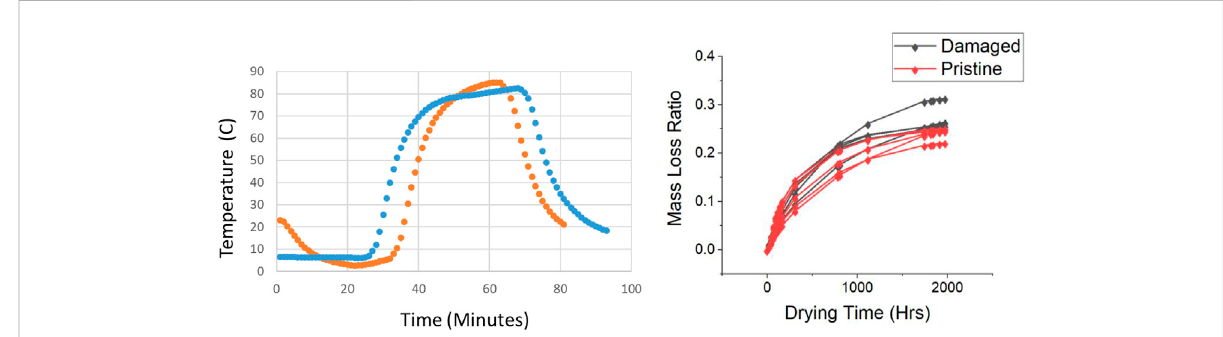
FIGURE 3 Temperaturepro fi lesfromanembeddedthermocouple withinsamplesduringtwosaturatedthermalcycleeventscomprisingofaicebathand heated water bath. The fi rst shocking cycle is colored blue and the second shocking cycle is colored orange (left). Gradual drying mass loss of damaged and pristine groups of neat cement paste prisms over time in a controlled environment. Mass loss ratio is de fi ned as mass loss at a speci fi c time to the initial mass of cement prism (right).